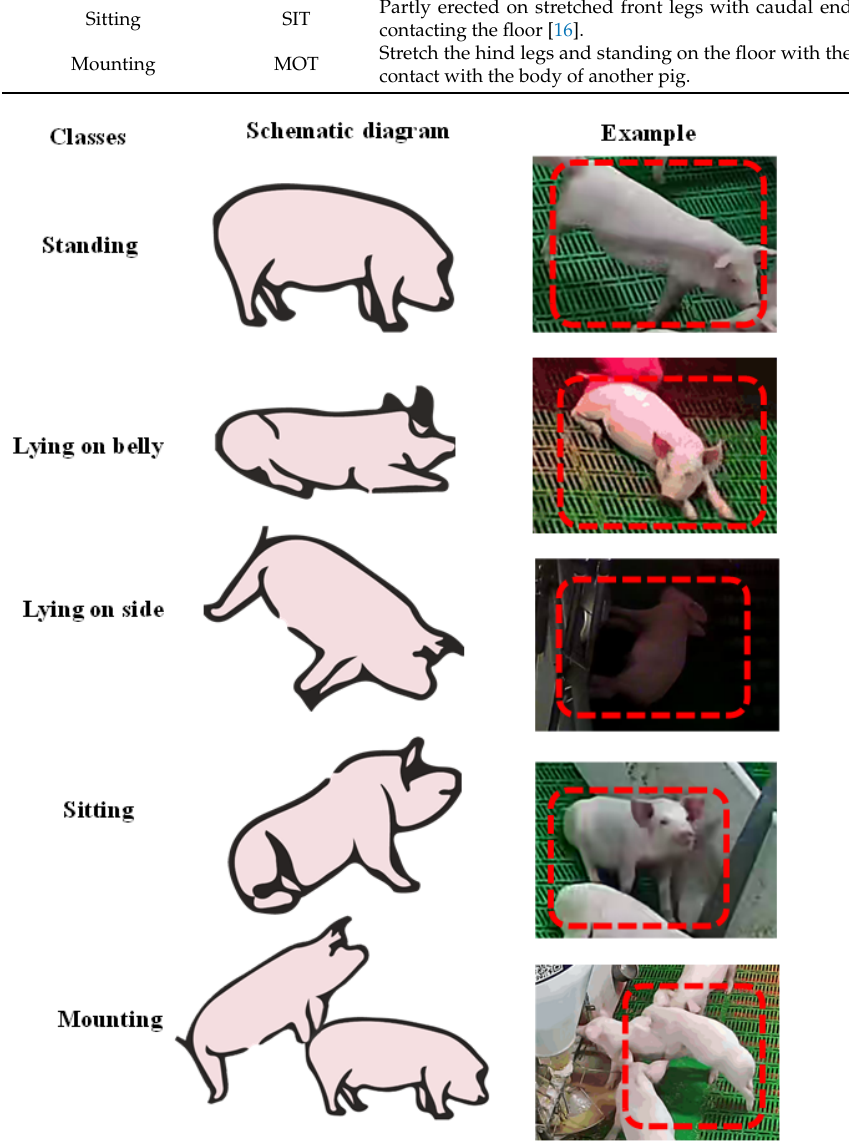
Figure 2. Definition of pig